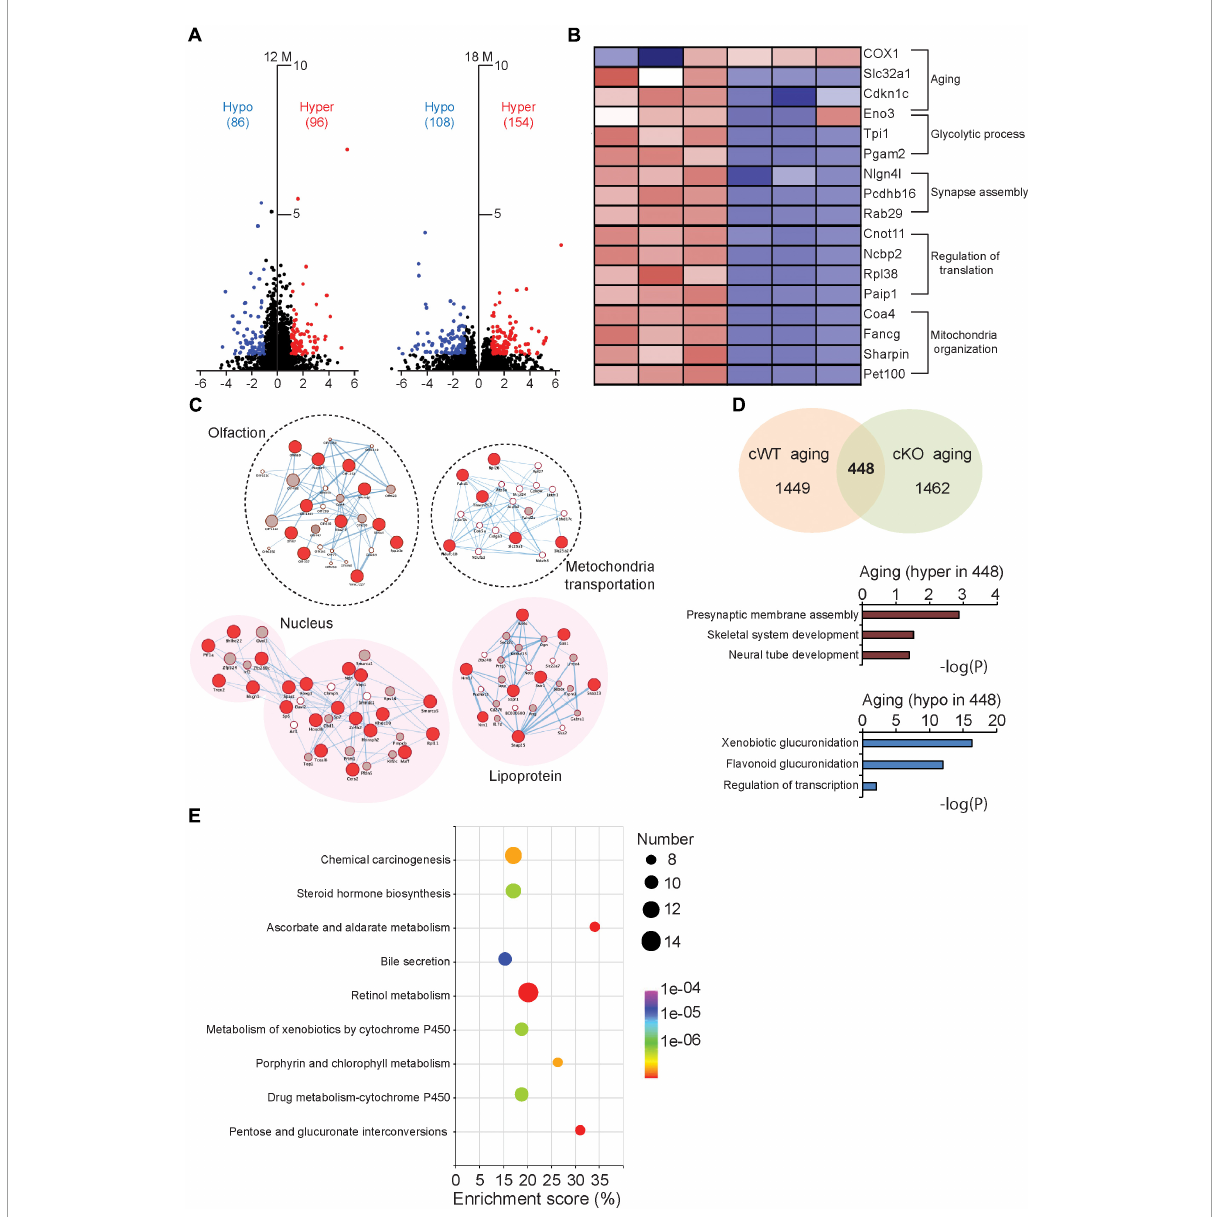
FIGURE5 Comparative analysis of the DMGs in Pitx3 cWT and Pitx3 cKO during aging. (A) The volcano plots of DNA methylation data collected from the striatum of Pitx3 cWT and Pitx3 cKO mice at 12 ( N = 3 mice per genotype; all males) and 18 months of age ( N = 3 mice per genotype; all males). (B) Supervised clustering for the DMGs data collected from the 12- and 18-month-old Pitx3 cWT mice. (C) Integrated map of GO terms enriched among the DMGs of Pitx3 cWT and Pitx3 cKO mice at 12 (background with white color) and 18 months of age (background with pink color). Red circles represented DMGs identified from our data. (D,E) 448 DMGs were identified during aging independent of genotype. They were analyzed with GO terms (D) and metabolic pathway (E) ,